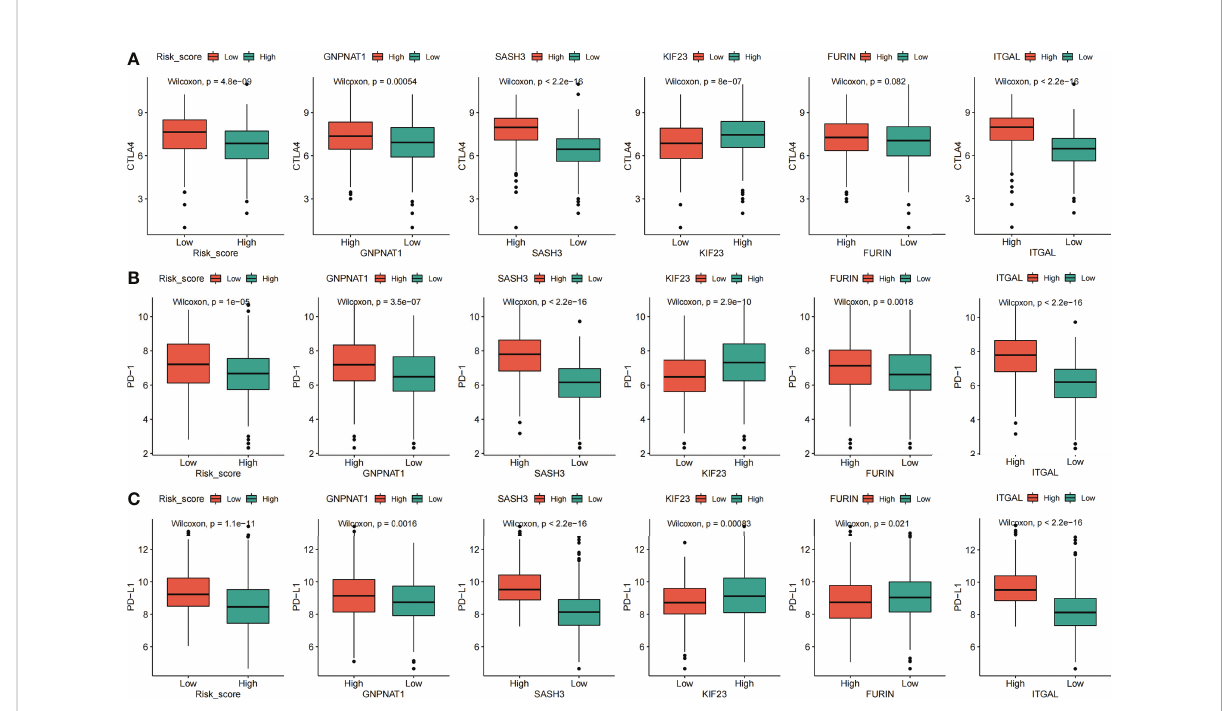
FIGURE 12 Correlation analysis between risk score, fi ve prognostic phagocytosis regulators signatures and immune checkpoints. (A) CTLA4. (B) PD-1. (C)